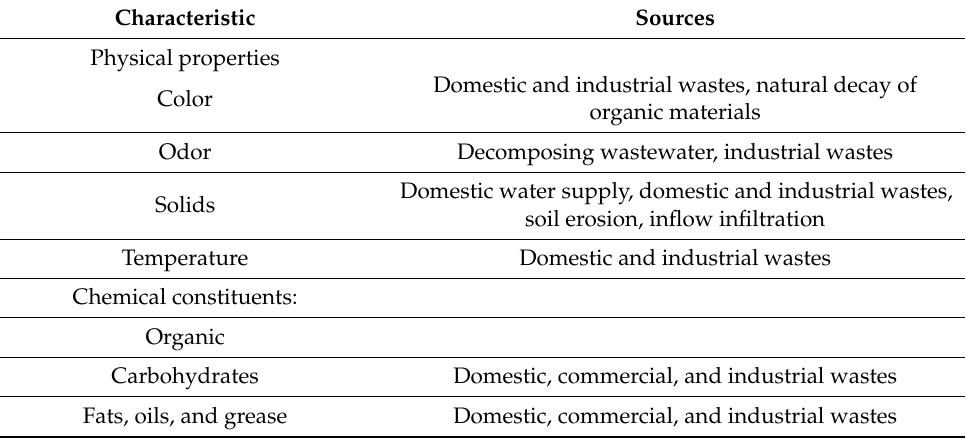
Table 1. Physical, chemical, and biological characteristics of wastewater and their sources